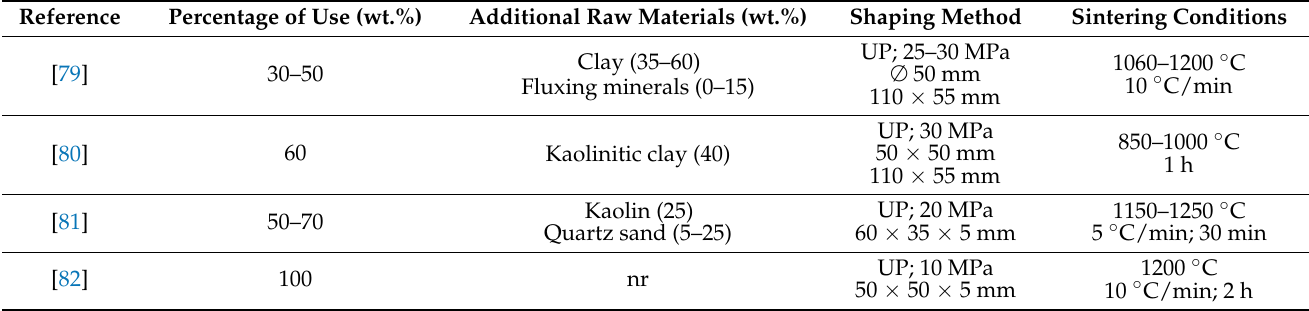
Table 2. Experimental conditions used in the development of mullite-based materials from iron mining waste. Reference Percentage of Use